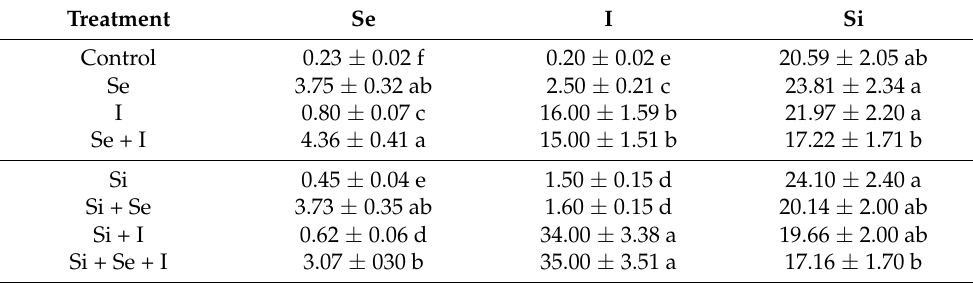
Table 4. Levels of Se, I and Si accumulation in chervil shoots under single and joint application of these